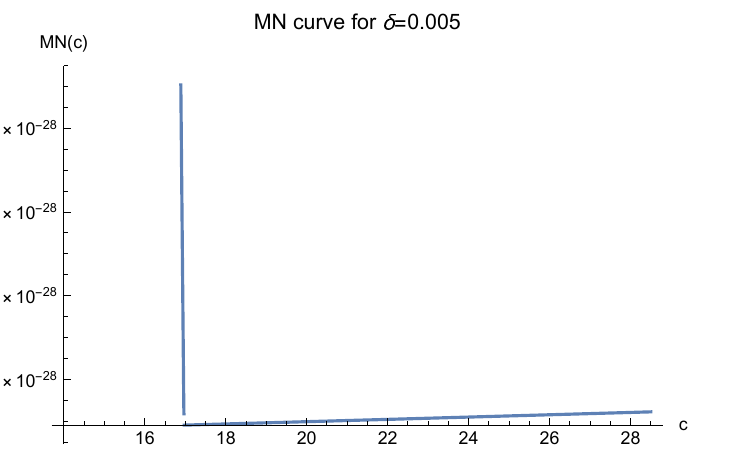
Figure 14. MN curve for δ = 0.005 where d = 2, β = 1, b 0 =